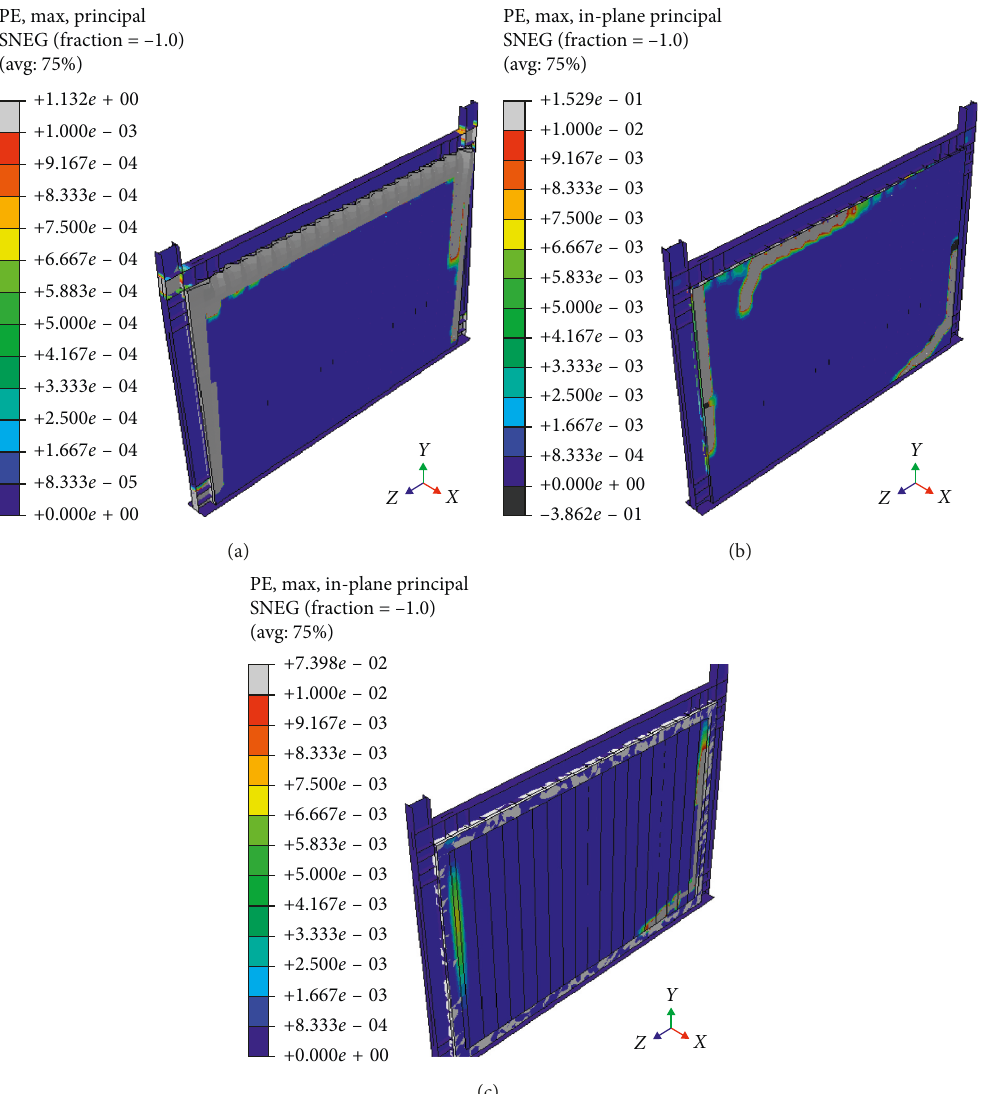
Figure 8: Results of the models in terms of damages in the infill walls. (a) M-1. (b) M-3. (c) M-4.